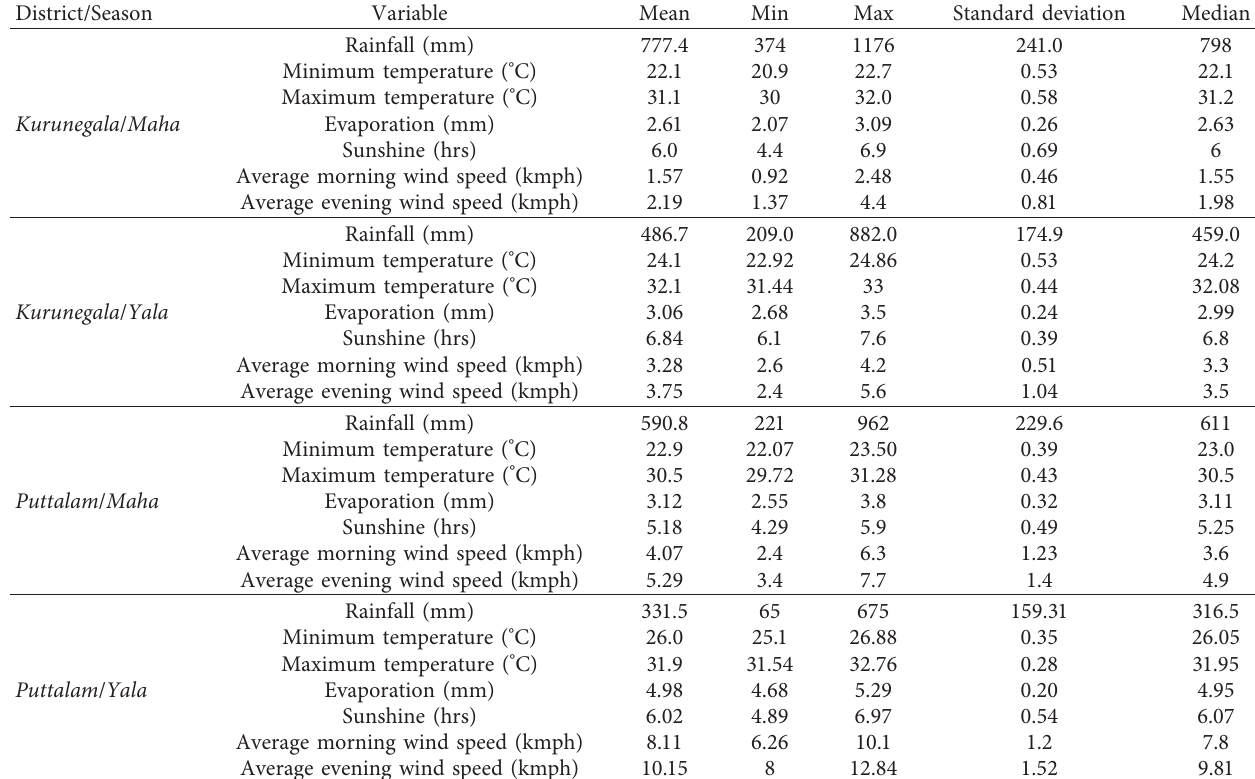
Table 2: Summary of the statistics of climatic